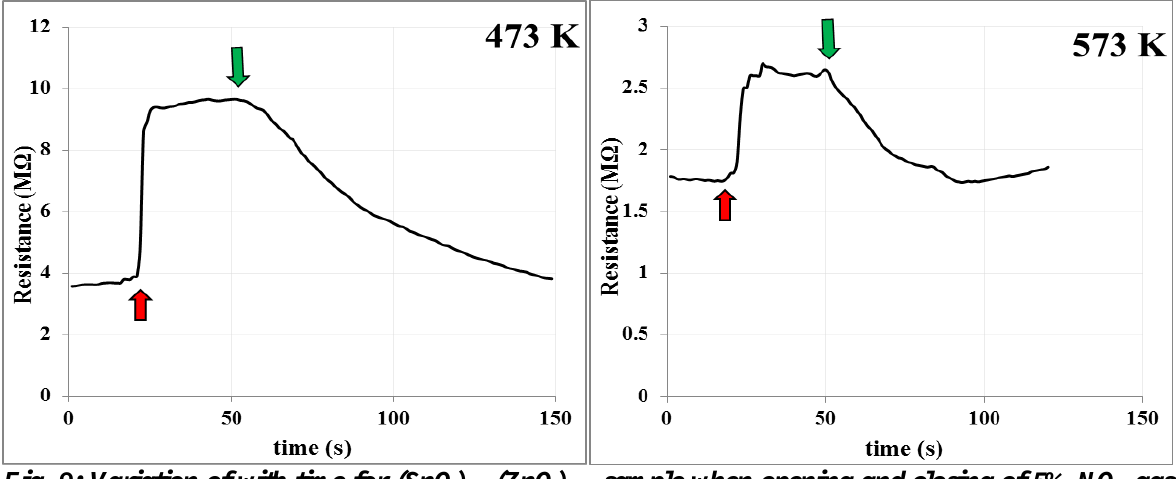
Fig. 9: Variation of with time for (SnO) at 473 and 573 K.